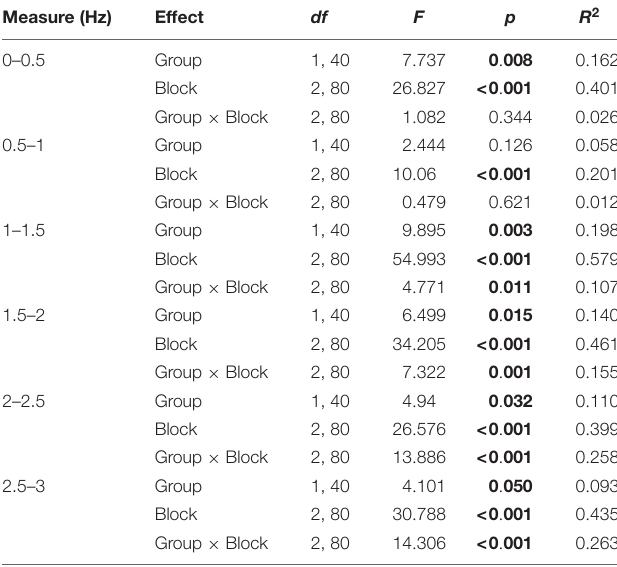
TABLE 4 | Experimental effects induced by exposure to virtual height: summary of linear mixed effect models for the PSD mean values of CoP displacement in anterior–posterior direction in selected frequency ranges.